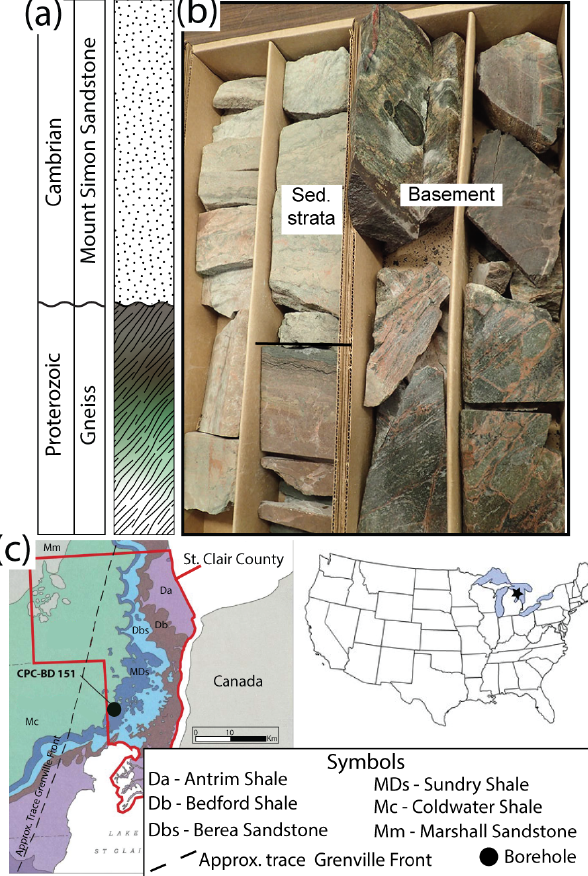
Figure 5. (a) Lithologic log of the CPC BD-139 core, Michi- gan, from 1404–1412.1m of measured depth. There are five main lithologic units identified, including sandstone, dolomitized and un- dolomitized finely foliated gneiss, and dolomitized and undolomi- tized gneiss with subhorizontal white veins. (b) Photographs of the CPC BD-139 core showing the core between ∼ 1404.5 and 1405.5m as well as contact between the Cambrian Mount Simon Sandstone (light tan) and the underlying Precambrian gneiss. The gneiss directly at the contact is fine-grained, tan, and dolomitized. This is underlain by green altered gneiss with subvertical pink frac- tures. This lithology grades into a dark grey gneiss with subhorizon- tal white veins (core between 1411.5 and 1412.5m), which extends through the bottom of the logged section. (c) Geologic map St. Clair County, Michigan; modified from Milstein